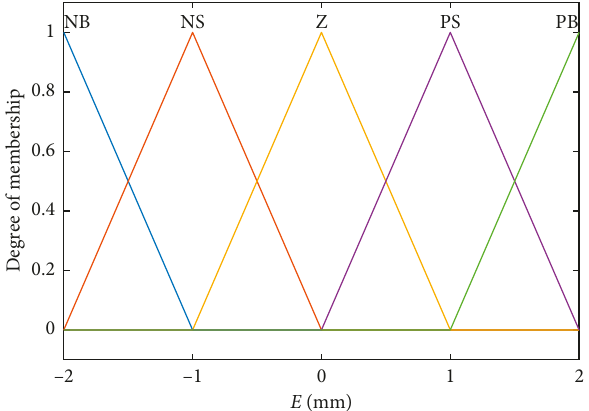
Figure 4: Triangular membership function.